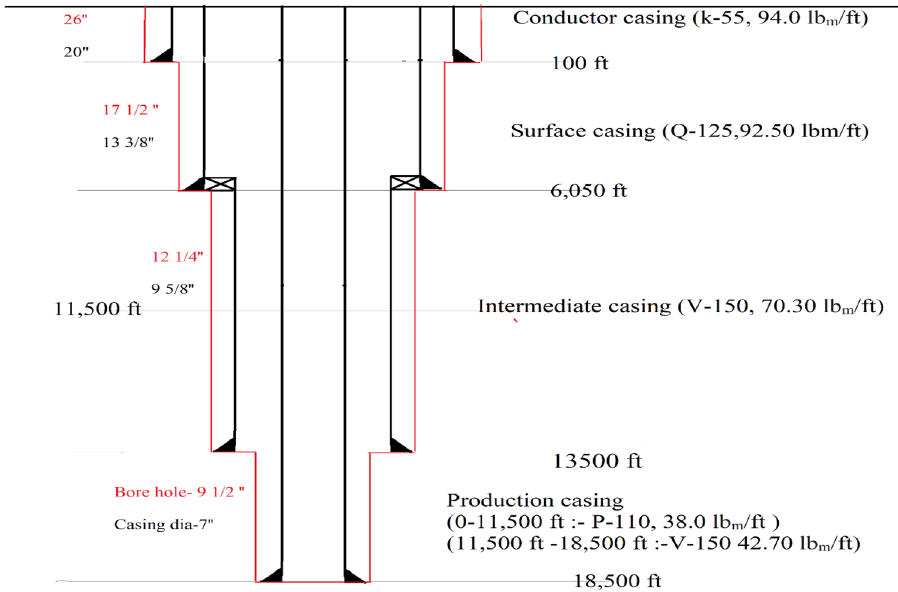
Fig. 22 Proposed well by modi- fied Eaton’s